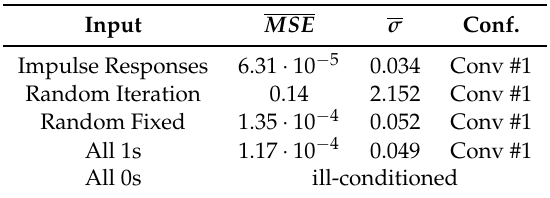
Table 6. Effect of the input type on the results of the CNN (filter order 1024). For each case, the best result and the related configuration is reported.